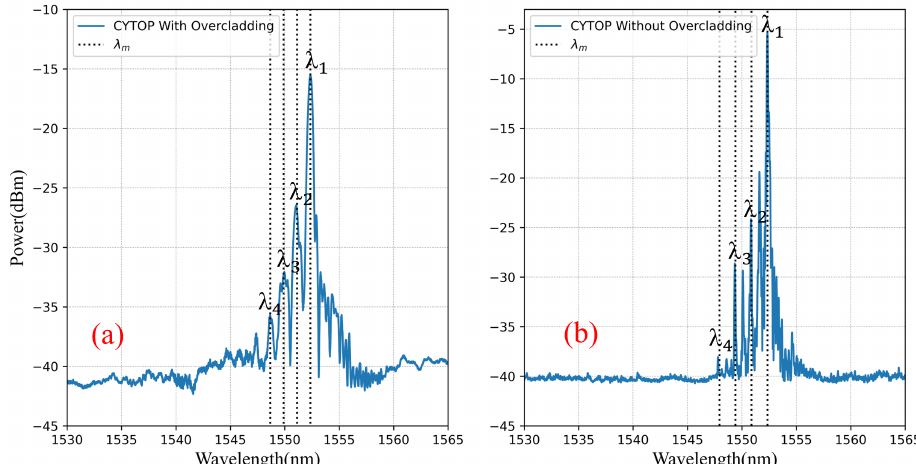
Figure 2. Reflection spectra for two gratings: ( a ) grating #1 in 62.5µm core diameter CYTOP with over-clad (inscription parameters: grating length 8mm, laser power 500µW, and inscription time 20s); ( b ) grating #2 in 50µm core diameter CYTOP without over-clad (inscription parameters: grating length 5mm, laser power 100µW, and inscription time